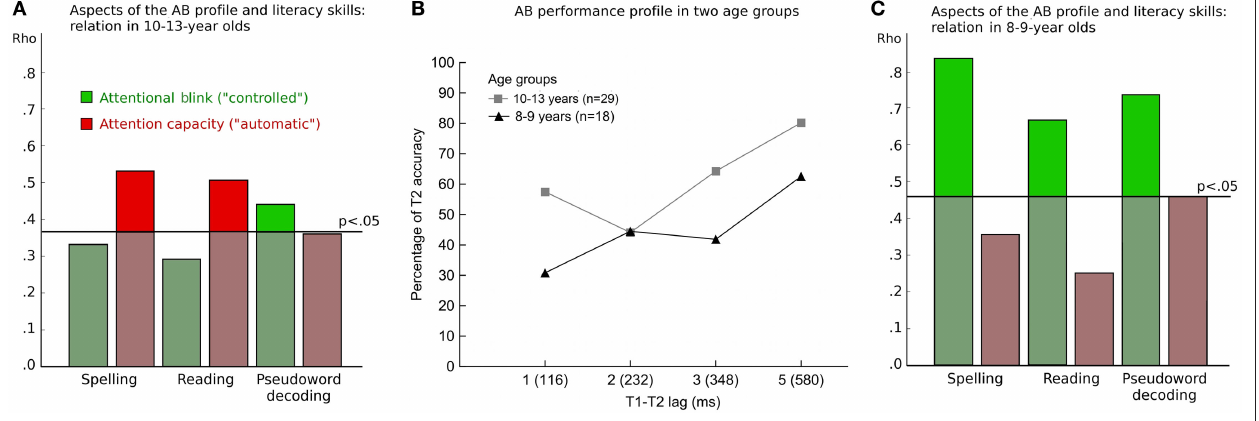
Figure 3 | (A) Bar plot showing the absolute rank correlation between measures derived from the attentional blink (AB) profile [shown in (B) ] and indices of literacy in children aged 10–13 years. Literacy scores were based on tests challenging spelling, reading, and pseudoword decoding. Attention profile measures were obtained by calculating (i) the relative decrease at lag 2 yielding in an index of the AB impairment, which characterizes the cost effect of “controlled” attention to the first target (T1), and (ii) the relative decrease at lag 1, where a relatively spared second target (T2) deficit measures the capacity for processing two targets in a